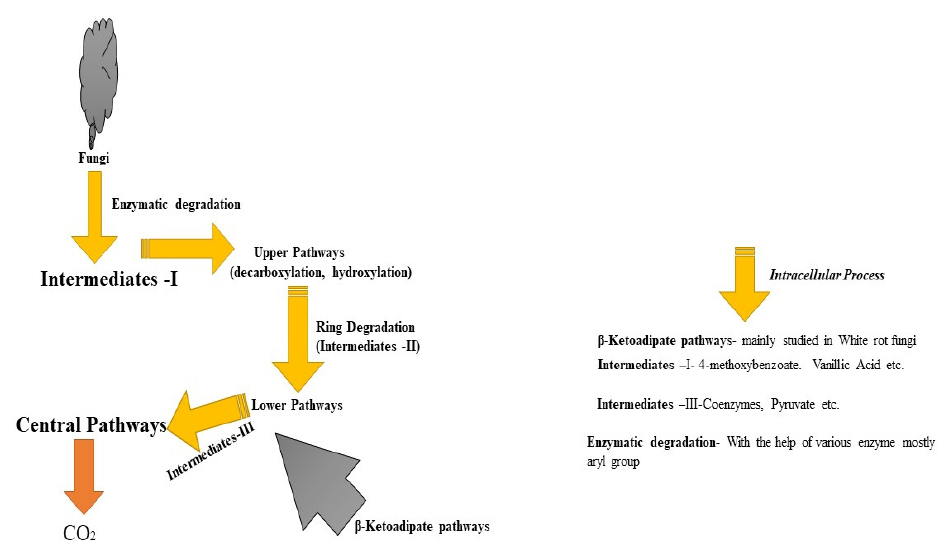
Figure 20. A hypothetical schematic representation of the biological pathways (fungal) involved in the depolymerization and degradation of the lignin [88].